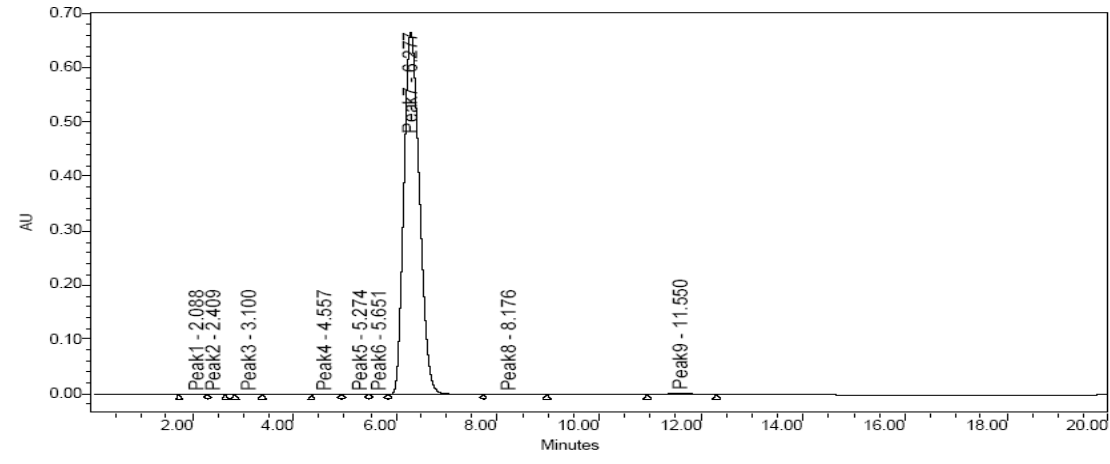
Figure 6. HPLC chromatogram of a mixture of equal amounts of a phlorhizin standard and the target compound.